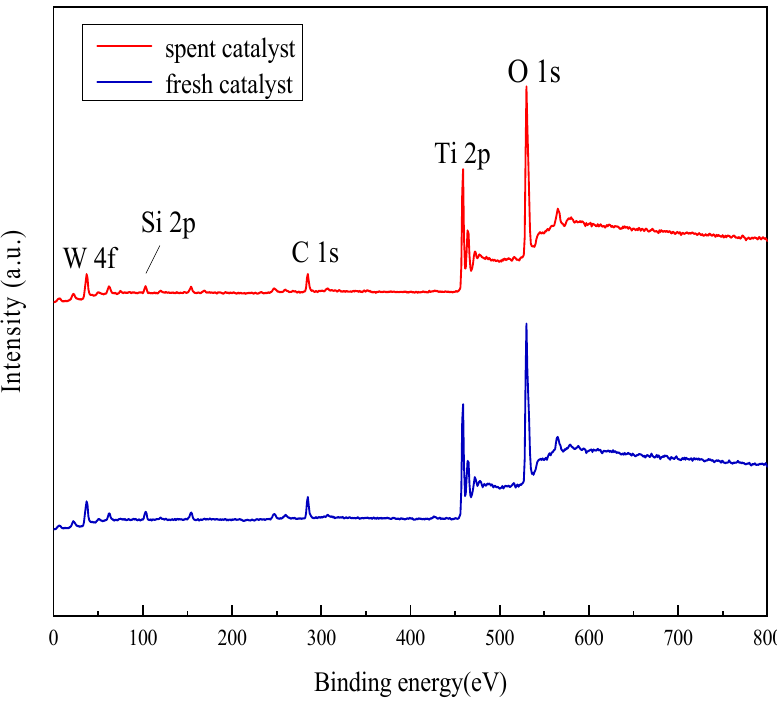
Figure 2. XPS spectra of SCR catalyst before and after deactivation.